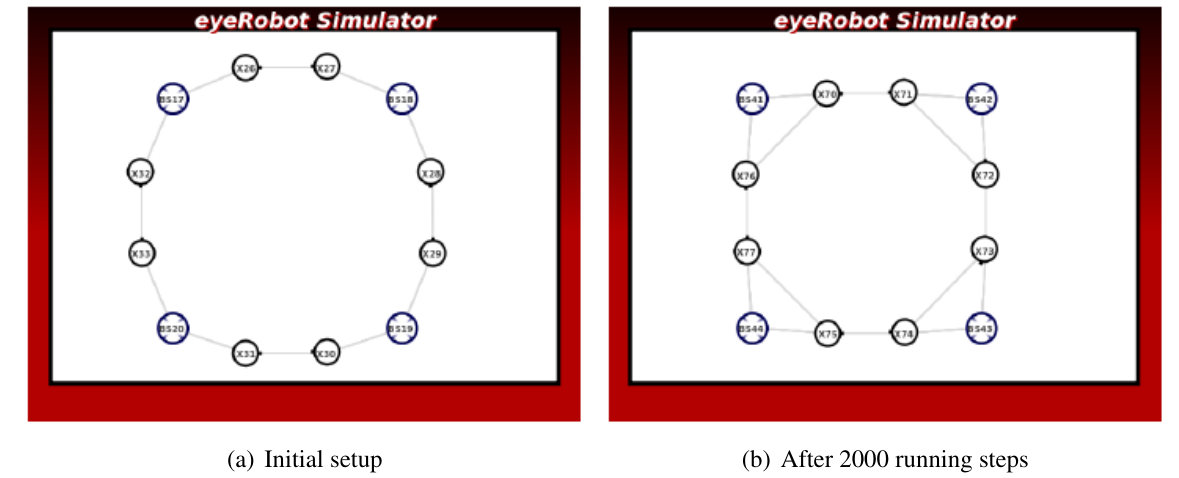
Figure 12. The experiment of the Circle scenario.